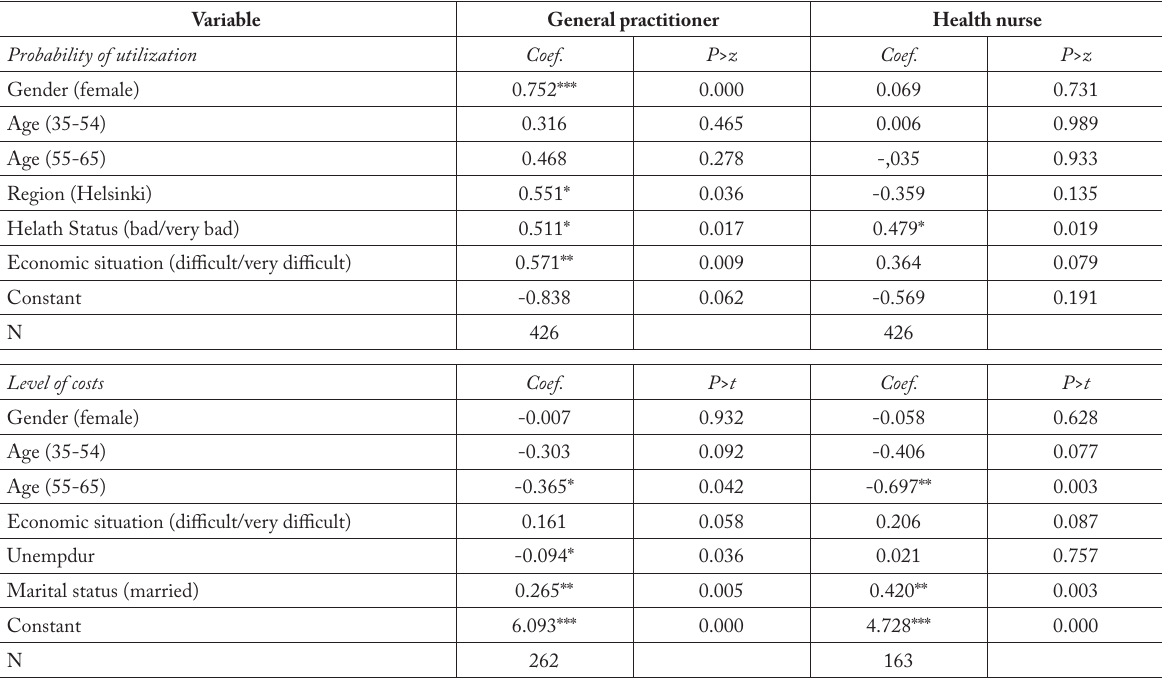
Table 2. Estimation results of the LTU probability (logit) and level models